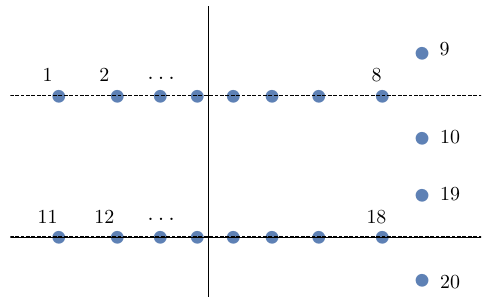
Figure 6. The pattern of Bethe roots for the winding state with w = (cid:0) 1, S z = 0 and L = 20. With the labeling as shown, the corresponding Bethe numbers are given by the reference distribution (32). The value of the parameters for the plot were taken to be (cid:13) = (cid:25)